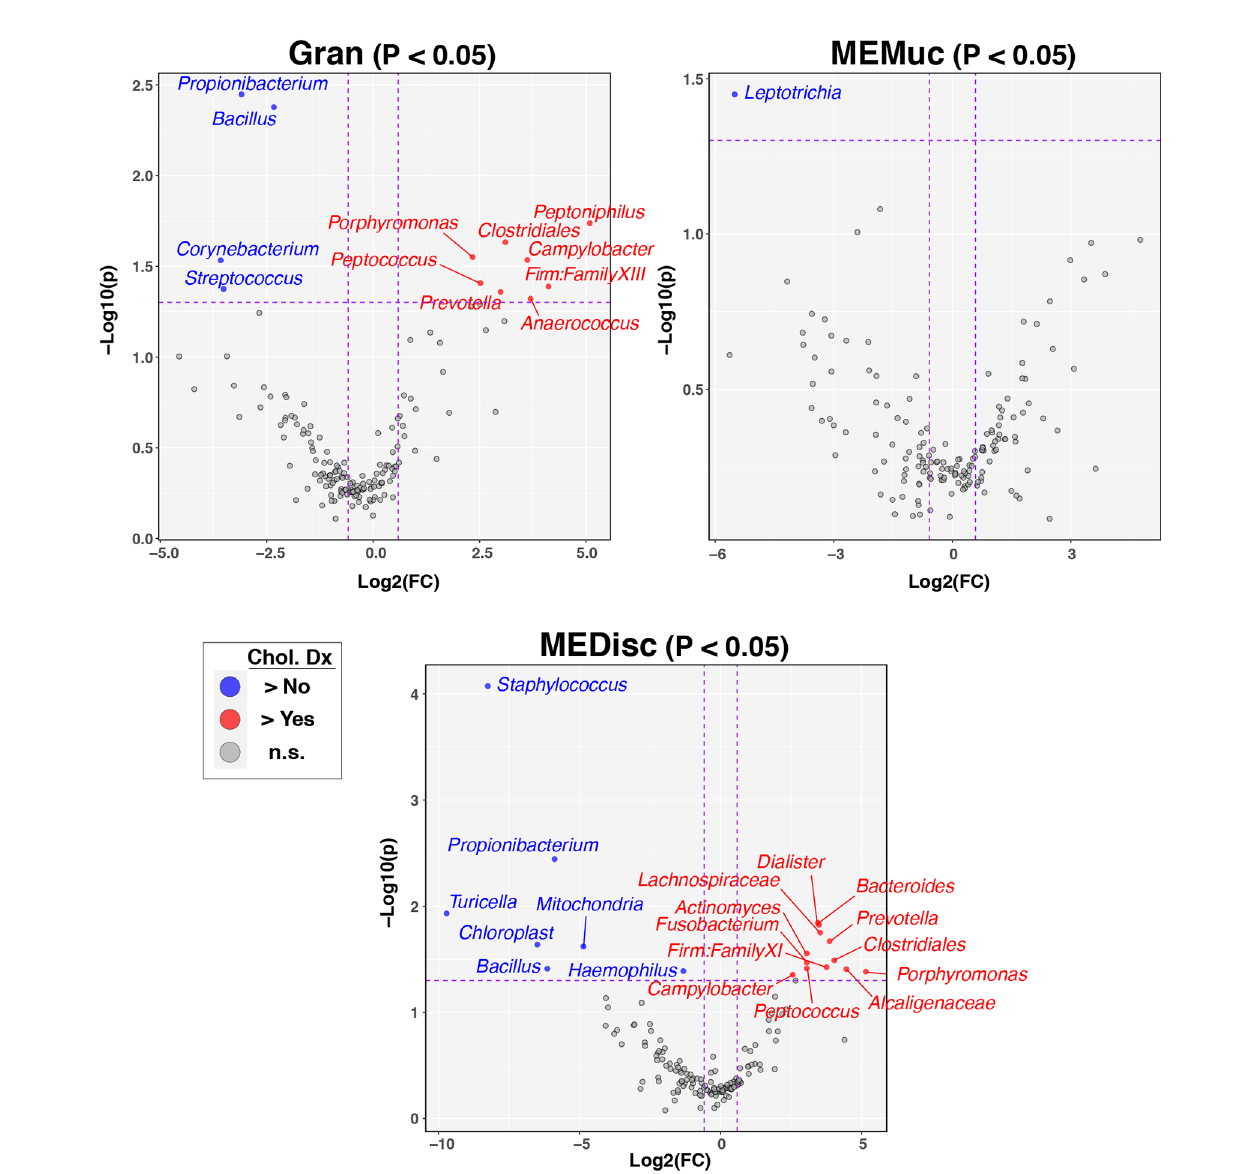
FIGURE 4 | Individual taxa differing between patients with and without cholesteatoma diagnosis. Between-group differences in the relative abundance of individual bacterial taxa were identi fi ed using the ANOVA-like differential expression (ALDEx2) test, which considers the compositional nature of microbiota datasets. The three panels show results strati fi ed by sample-type (Gran, MEMuc, or MEDisc). Vertical dashed lines indicate fold-change cutoffs ≥ 1.5. Horizontal dashed lines show p- value cutoffs for comparisons (nominal p ≤ 0.05). Blue circles in the upper left quadrants denote taxa enriched in patients without cholesteatoma diagnosis while red circles in the upper right quadrants denote taxa enriched in patients with cholesteatoma